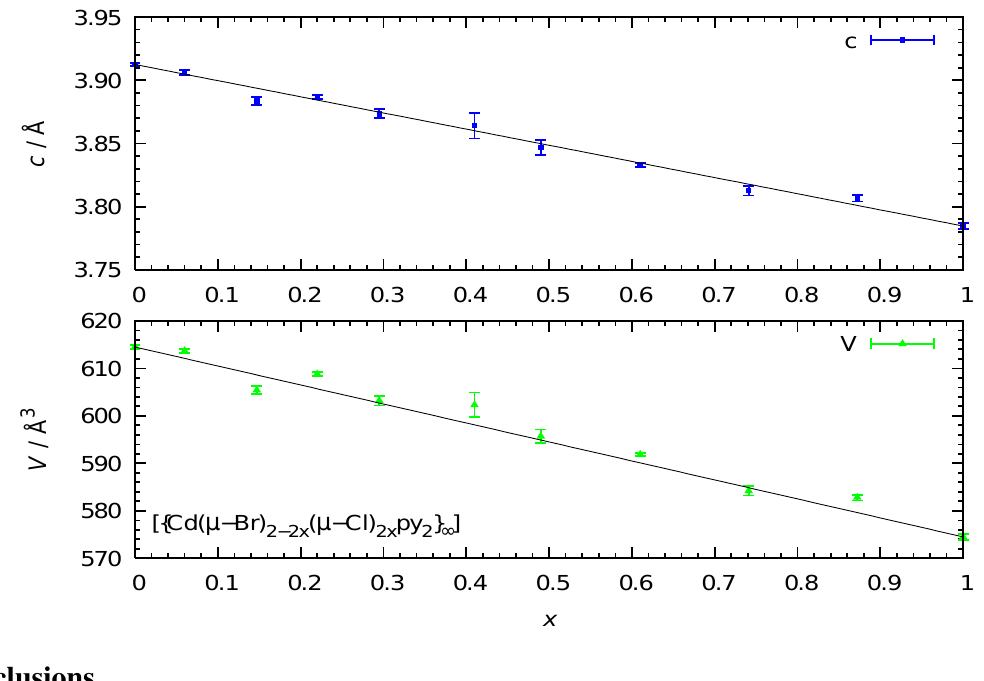
Figure 5. Unit cell volume and Cd · · · Cd distance (lattice parameter c ) dependency on halide ratio displaying Vegard behavior (line suggests ideal values). Parameters from SCXRD (see Tables 1 and 2) and halide ratio from ion